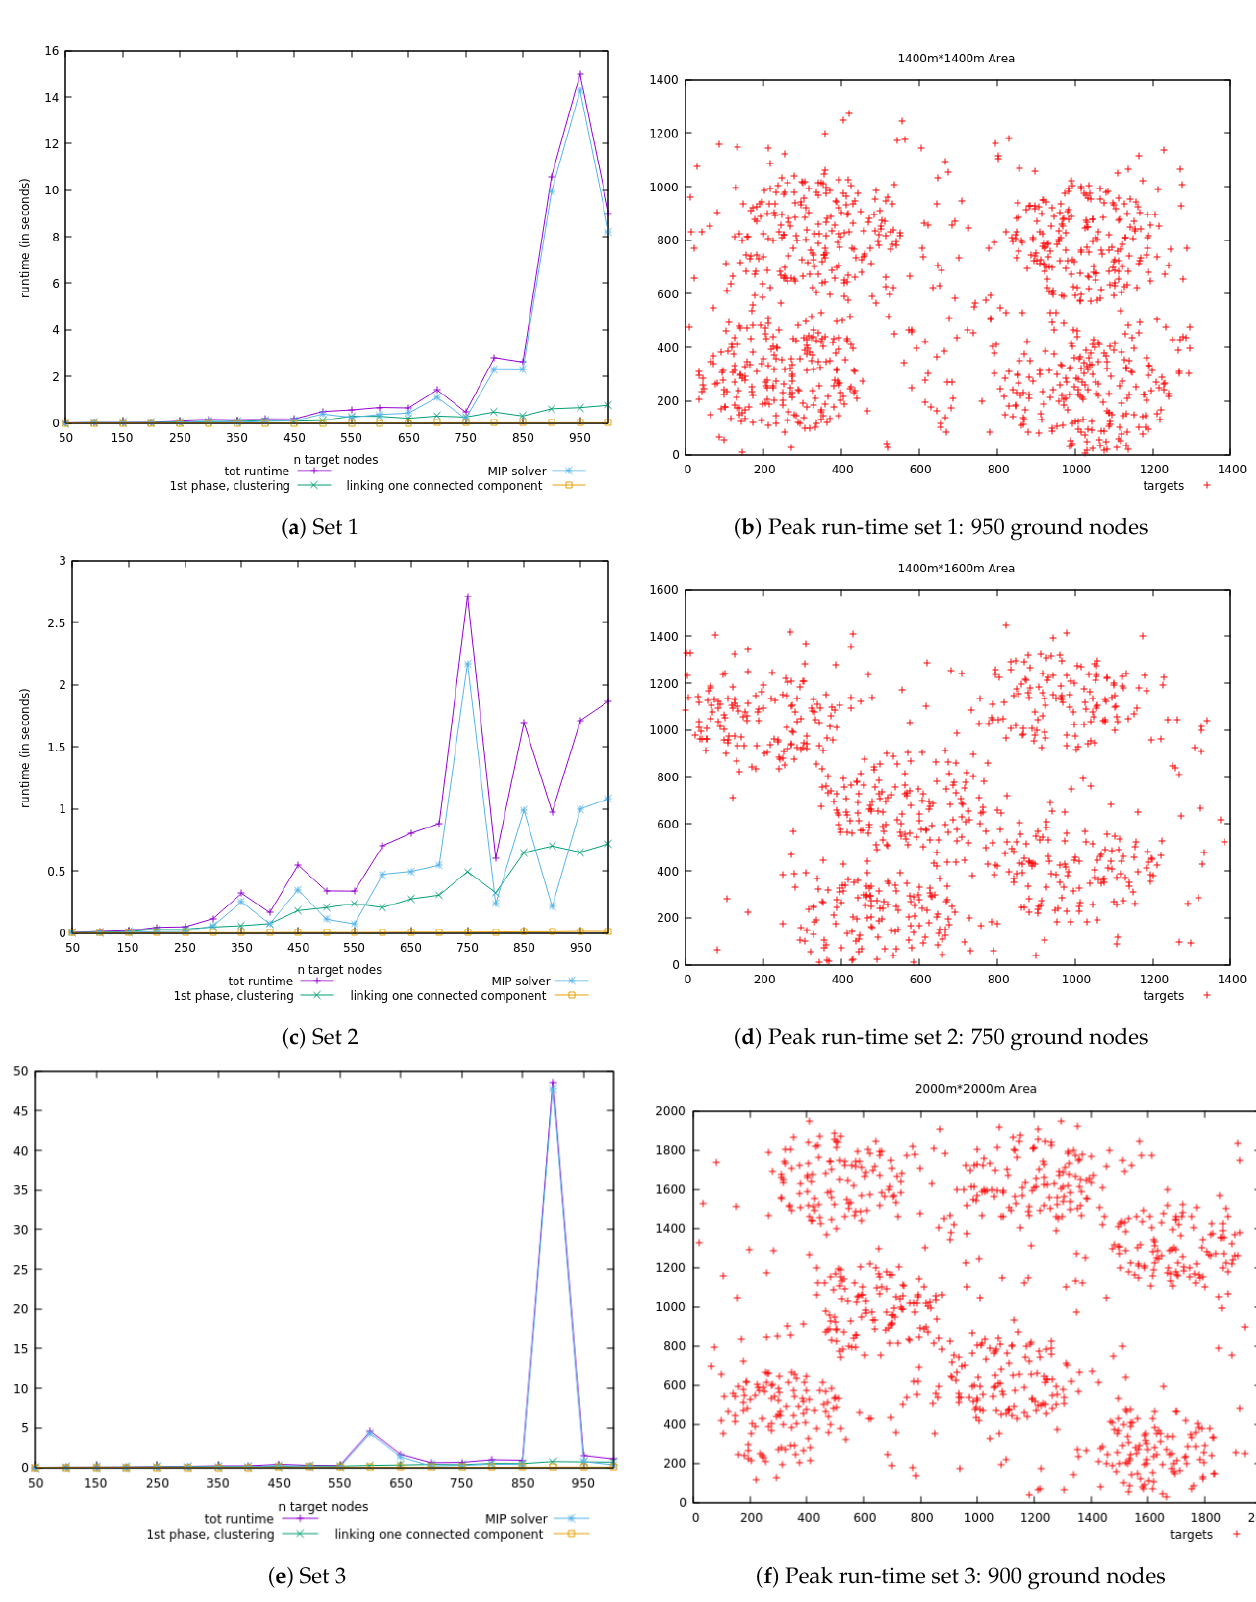
Figure 9. Datasets overall run-time and specific to the 3 main steps; and distribution of instance with highest execution time (Part